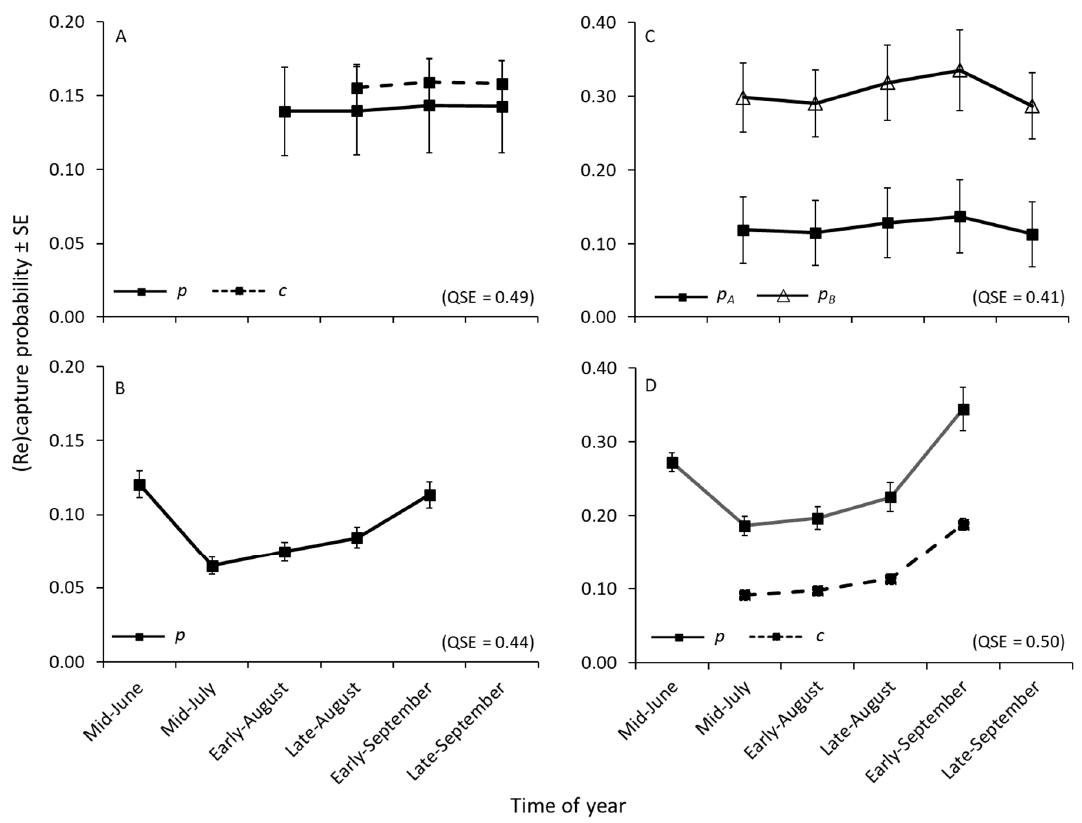
Figure 2. Capture ( p ) and recapture ( c ) probabilities ( ± SE) for native Medionidus conradicus ( A = 2011, B = 2012) and Actinonaias pectorosa ( C = 2011, D = 2012) by CMR sampling occasion at Cleveland Islands, Upper Clinch River, Russel County, Virginia estimated using closed-capture models in Program MARK. Best approximating models for A. pectorosa in 2011 ( C ) indicated heterogeneity in capture probabilities ( π = 0.59 = probability an individual belongs to mixture A), where 𝑝 (cid:3002) = capture probabilities for mixture A and 𝑝 (cid:3003) = capture probabilities for mixture B. Raw estimates of quadrat sampling efficiency (QSE) on the substrate surface in late September are shown for comparison.